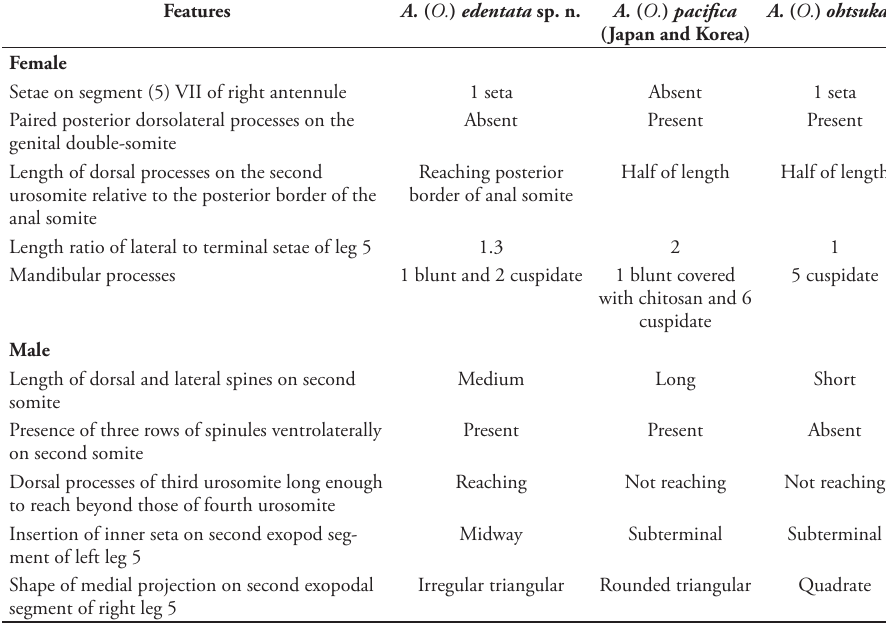
Table 2. Differences in morphological characteristics among Acartia ( Odontacartia ) edentata sp. n., A. ( O. ) pacifica from Japan and Korea, and A. ( O. ) ohtsukai . Features